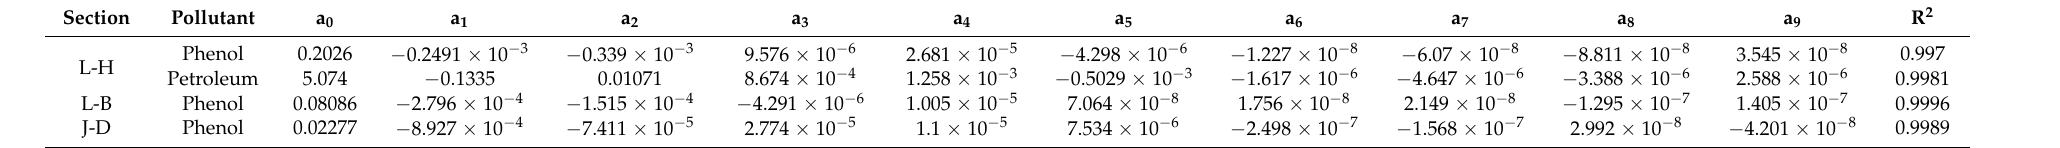
Table 12. The parameter values that resulted from the computer numerical